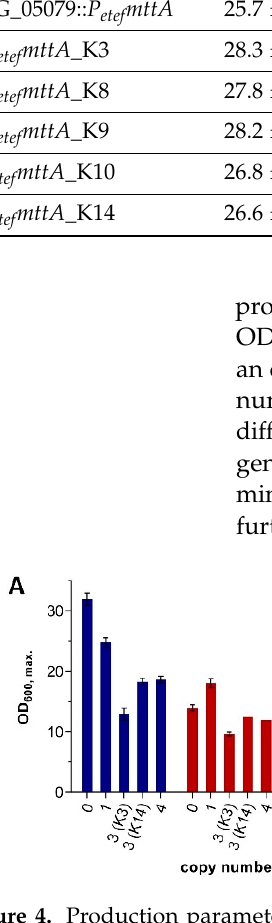
Figure 4. Production parameters of U. maydis MB215 ∆ cyp3 ∆ MEL ∆ UA ∆ dgat ∆ P ria1 :: P etef ∆ fuz7 transformants with different mttA copy numbers incubated in MTM with 50 g L − 1 glucose and 100 mM MES ( A ) and with 100 g L − 1 glucose and 66 g L − 1 CaCO 3 ( B ). Error bars indicate the standard error of the mean ( n = 3).